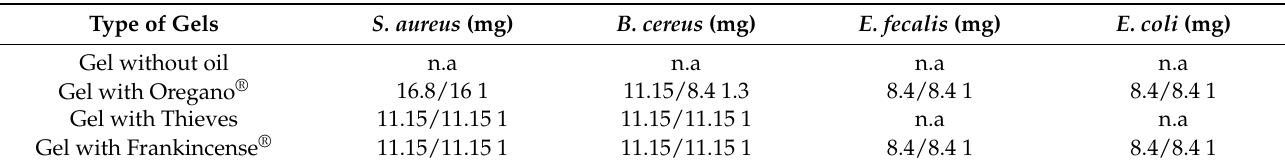
Table 3. Antibacterial activity (MIC/MBC